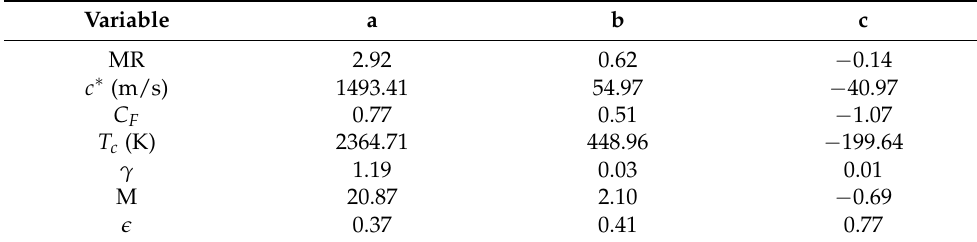
Table 5. Fitted data for RFNA and RP1; p e 0.7 bar.